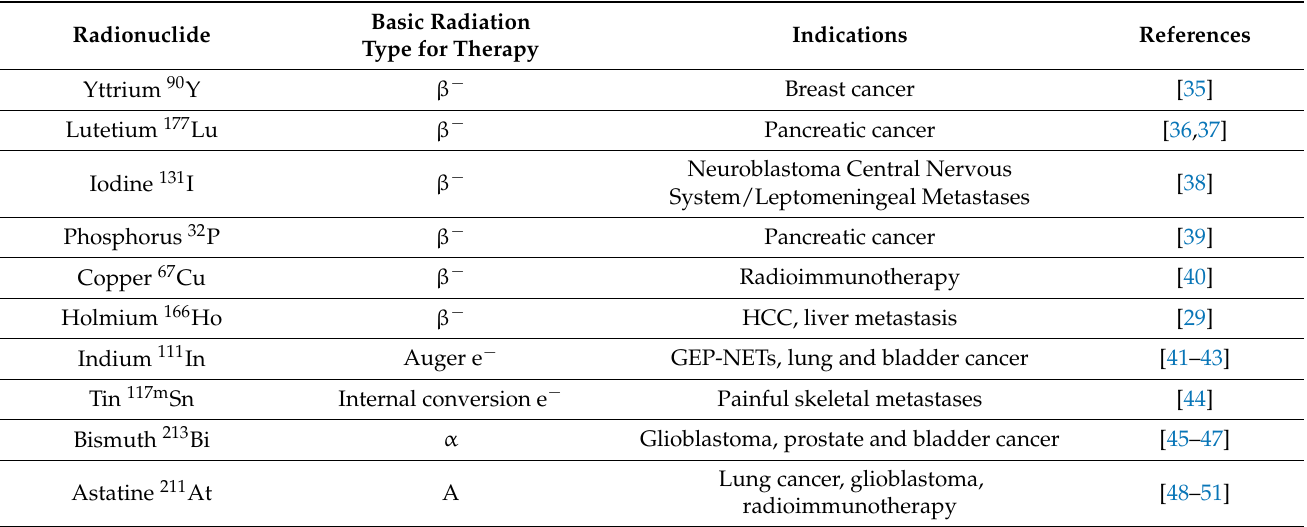
Table 2. Radionuclides currently introduced into radioisotope therapies, at the stage of research. Basic Radionuclide